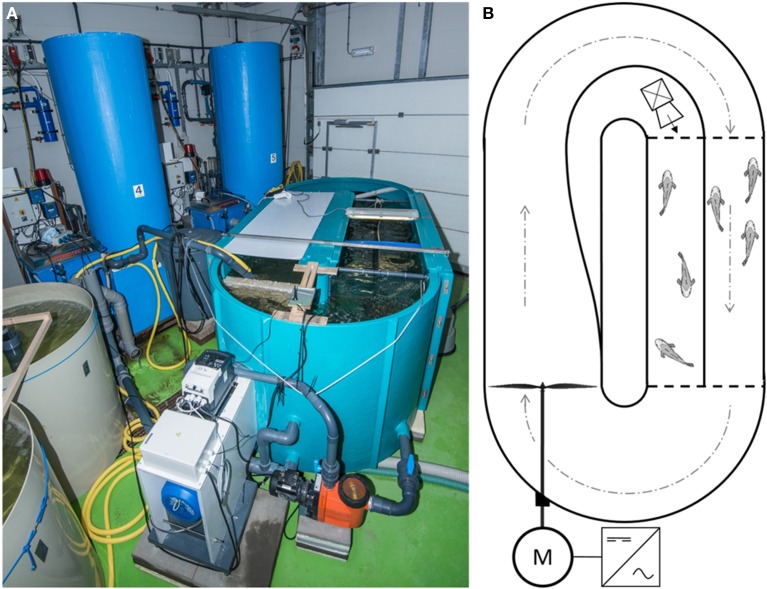
The constructed swim-flume. (A) side-view; and (B) schematic overview. An industrial inverter provided an alternating current with adjustable frequency (Hz) to an electric motor, which in turn powered the impeller. Water was led through the swimming compartment, forcing fish (n = 23) to swim at the optimal swimming speed. Fish (n = 23) in the rest-compartment were not subjected to water flow and displayed spontaneous activity. To maintain high water quality in the rest-compartment, low water flow was generated by a small pump, which was placed in the curve outside the compartment. See text for detailed description.